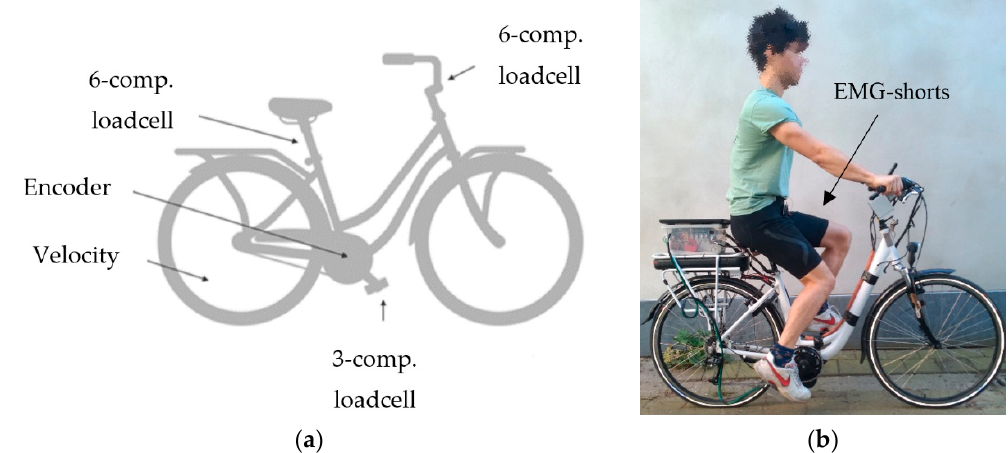
Figure 1. ( a ) Schematic overview instrumented bicycle; ( b ) test subject on instrumented bicycle.